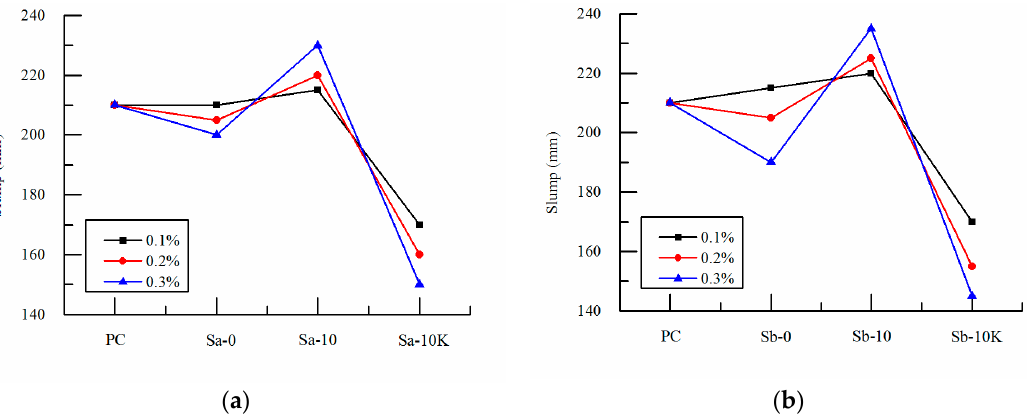
Figure 2. Effects of SAP on slump of concrete: ( a ) SAP-a; ( b ) SAP-b, S-10 and S-10K are pre-absorbed, and S-0 is non-absorbed.